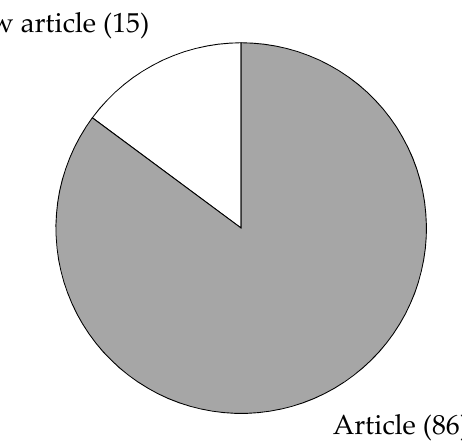
Figure 1. Number of selected articles according to article type.